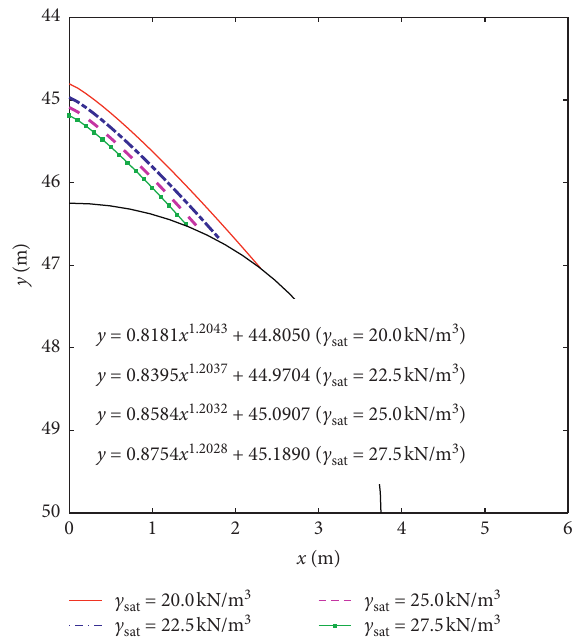
− h w t ) on collapse